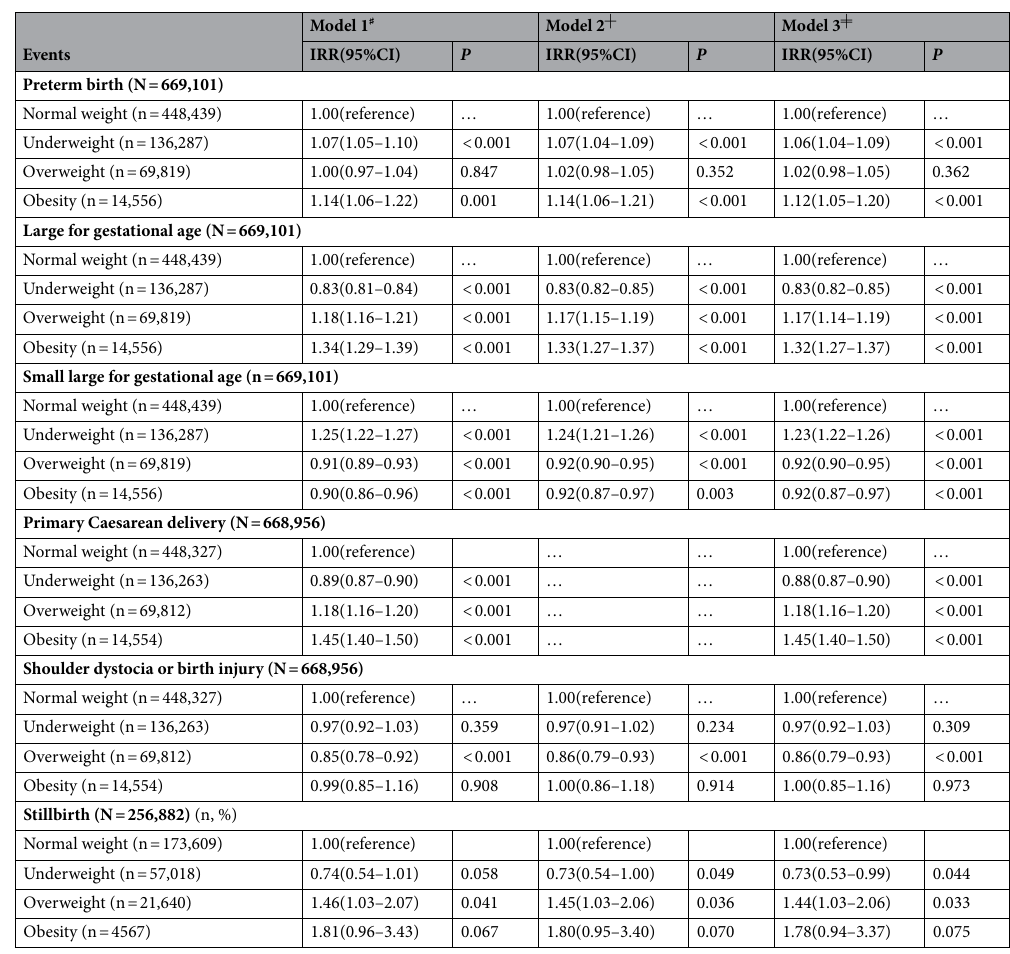
Table 3. Adjusted risk ratios for adverse pregnancy outcomes according to maternal pre-pregnancy BMI. IRR incidence risk ratio. ♯ Model 1: risk ratios were adjusted for sociodemographic characteristics of maternal (age, education level, occupation, ethnicity, region and migrant population). ┼ Model 2: risk ratios were additionally adjusted for history of pregnancy (first gestation and primipara) and history of adverse pregnancy outcomes (preterm birth, miscarriage, induced abortion, birth defect, and stillbirth) except for primary caesarean delivery. ╪ Model 3: risk ratios were adjusted for pre-pregnancy body mass index, active smoking, passive smoking, husband smoking and alcohol consumption status of maternal before pregnancy and active smoking, husband smoking, alcohol drinking status during early stage of pregnancy, in additional to the covariates in Model